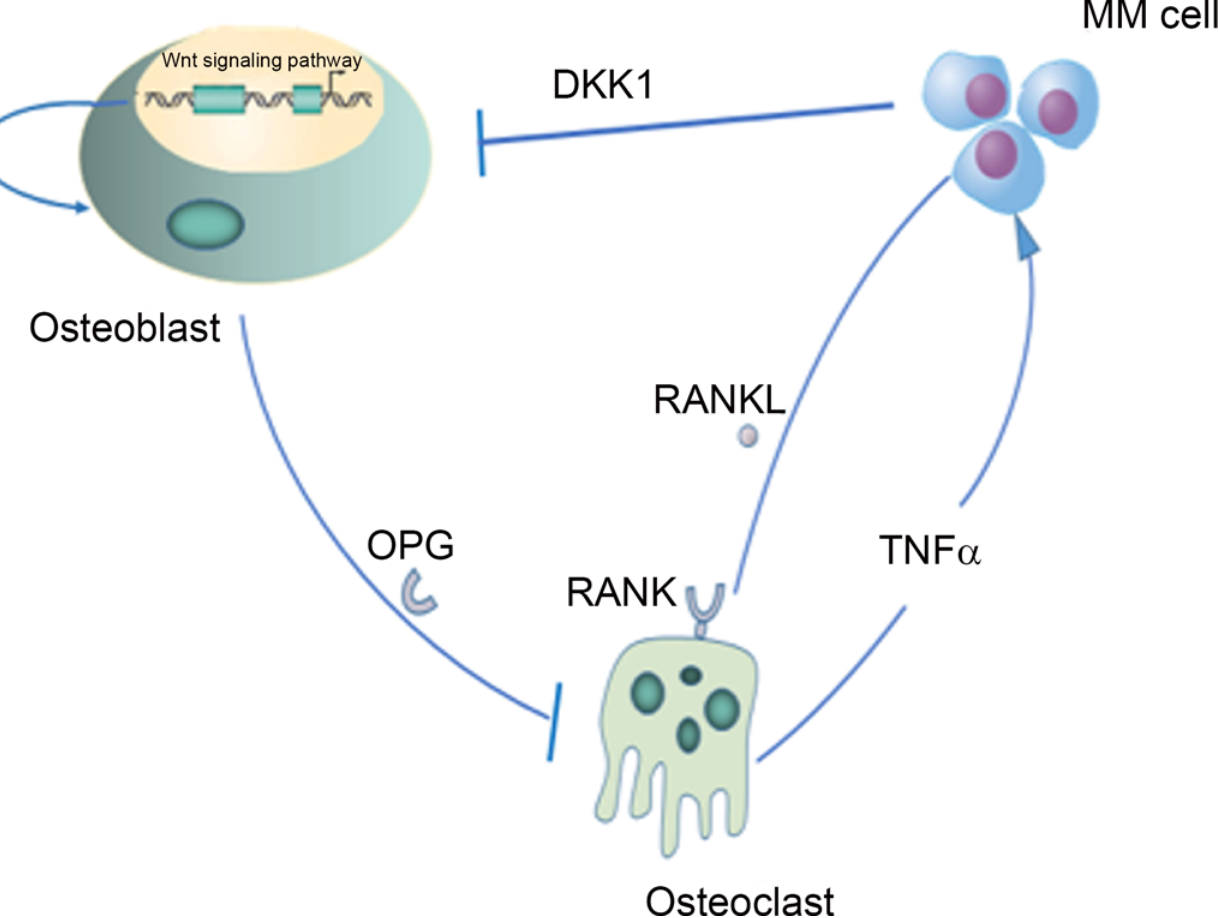
Fig 1. The signaling pathway for MMs, OBs and OCs. I : The Wnt signaling pathway stimulates the growth, differentiation and activity of osteoblasts. II: Dickkopf (DKK1) inhibits the phosphorylation of beta-catenin to prevent its degradation. III: The ratio of OPG/RANKL is negatively related to the number of OCs. IV: TNF α stimulates the formation of MMs and induces stromal cells to secrete factors, such as RANKL, that drive OC